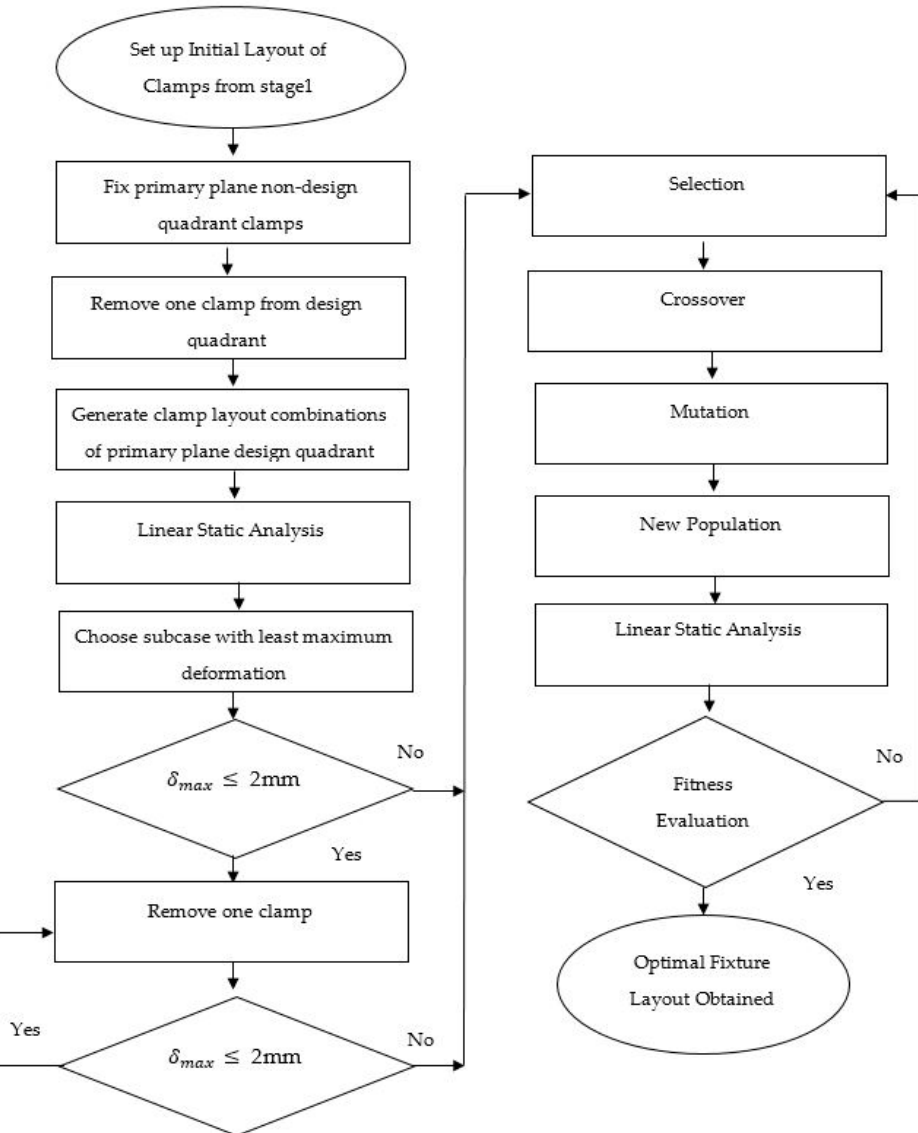
Figure 4. Stage 3 flowchart for fixture layout optimization using genetic algorithm.